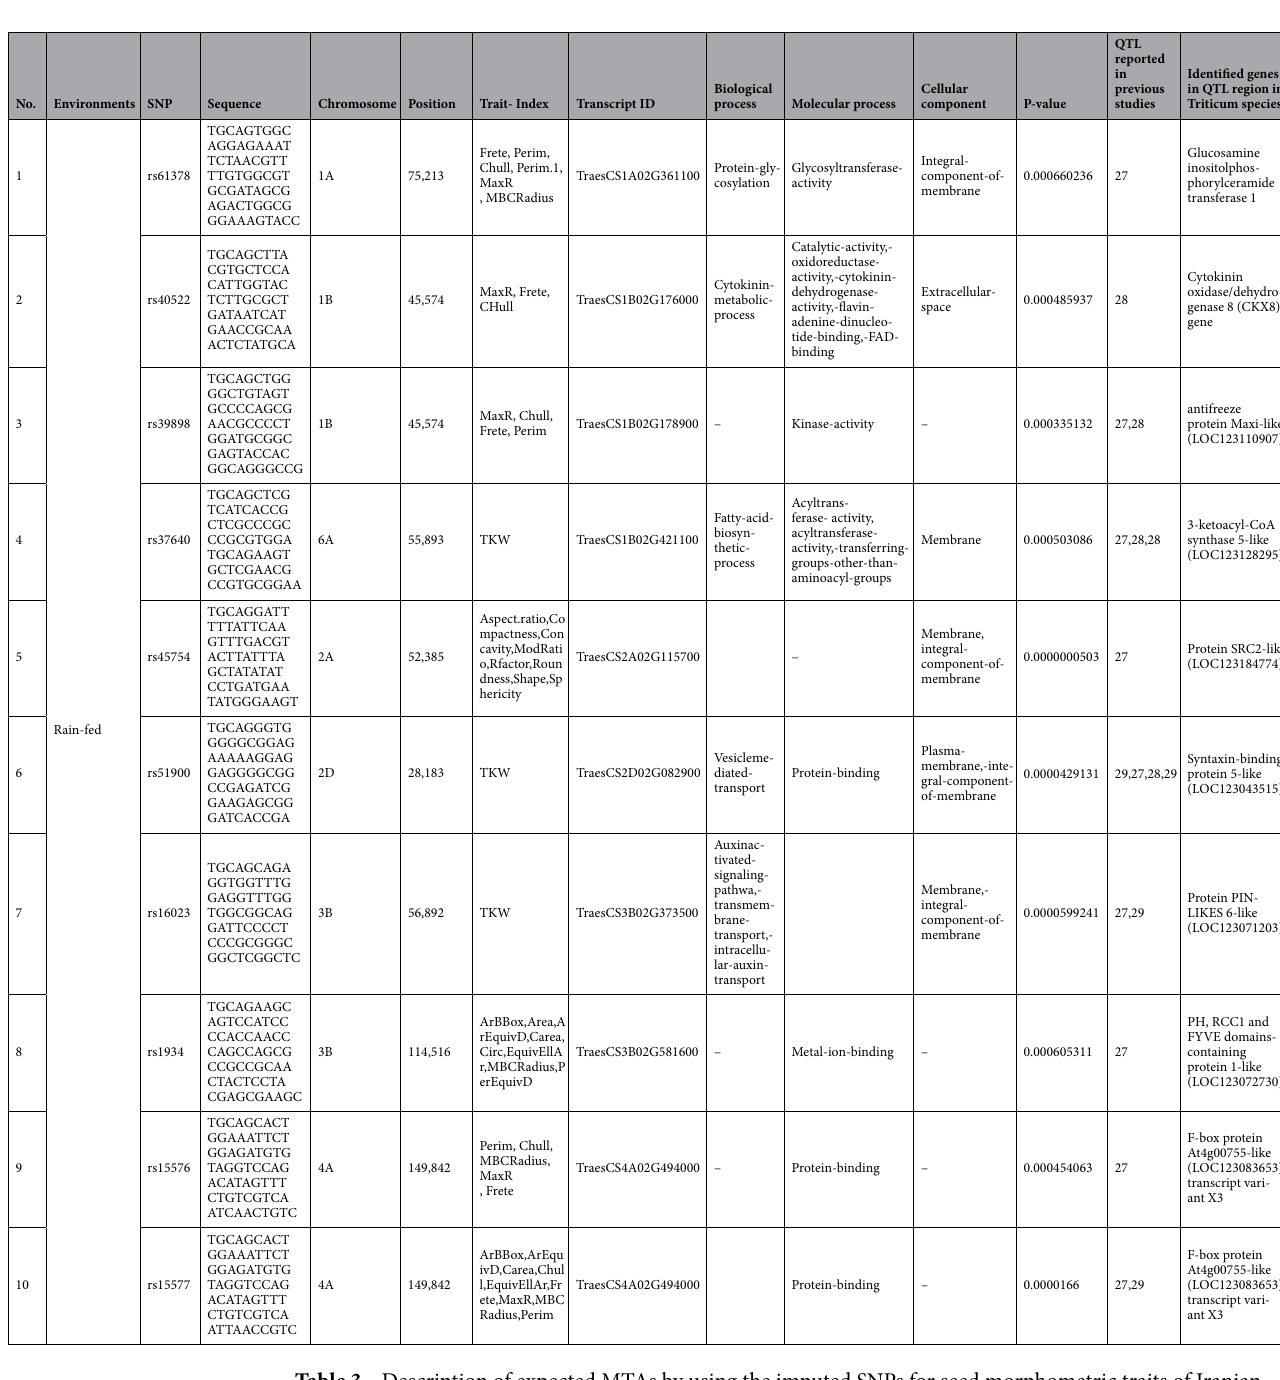
Table 3. Description of expected MTAs by using the imputed SNPs for seed morphometric traits of Iranian wheat accessions exposed to the well-watered and rain-fed